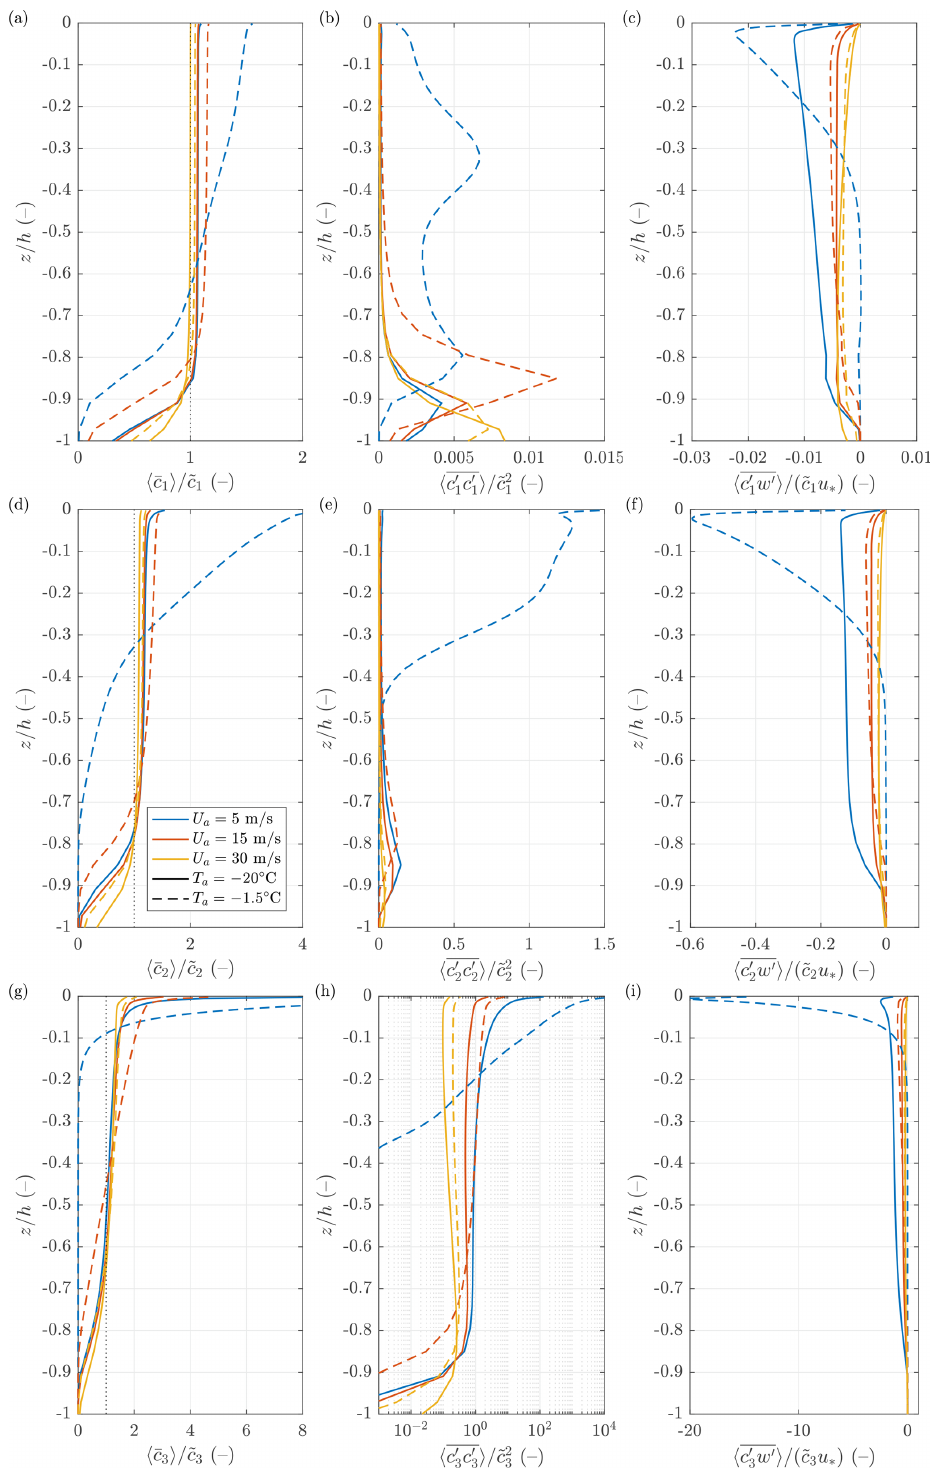
Figure 6. Vertical profiles of the mean (a, d, g) , variance (b, e, h) , and vertical flux (c, f, i) of the frazil volume fraction for size classes 1–3 for different combinations of U a (colors) and T a (line styles). Note the different x -axis ranges in the plots; in (h) , the x axis is